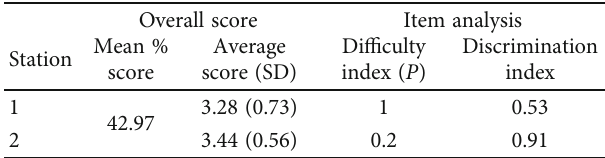
Table 3: Overall analysis of the situated simulation-based exam.